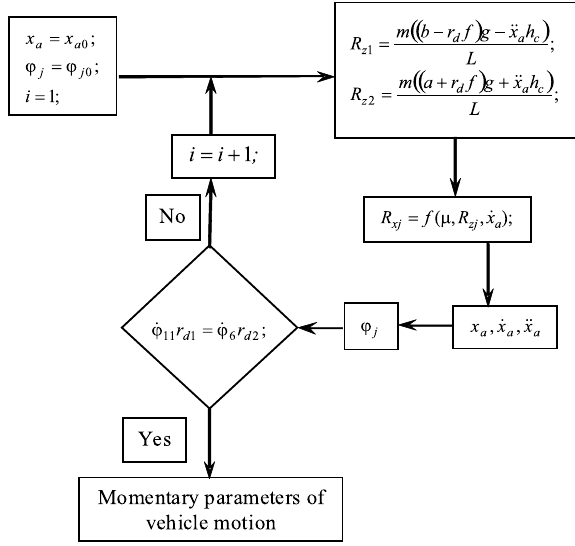
Fig. 4. Algorithm describing the tyre and road interaction (Starevičius